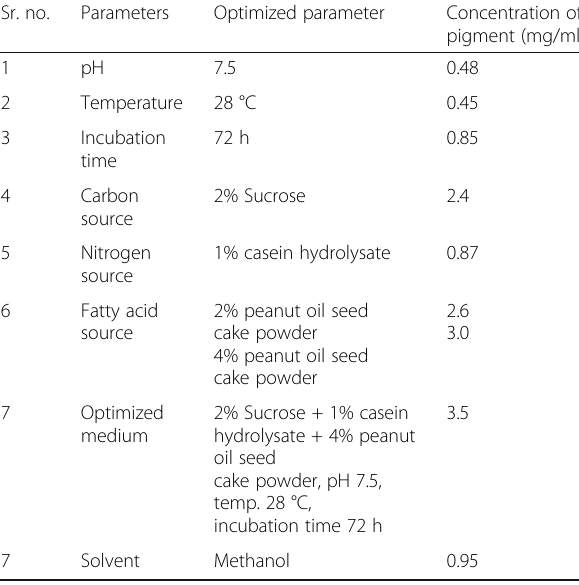
Table 1 Summary of optimized parameters for